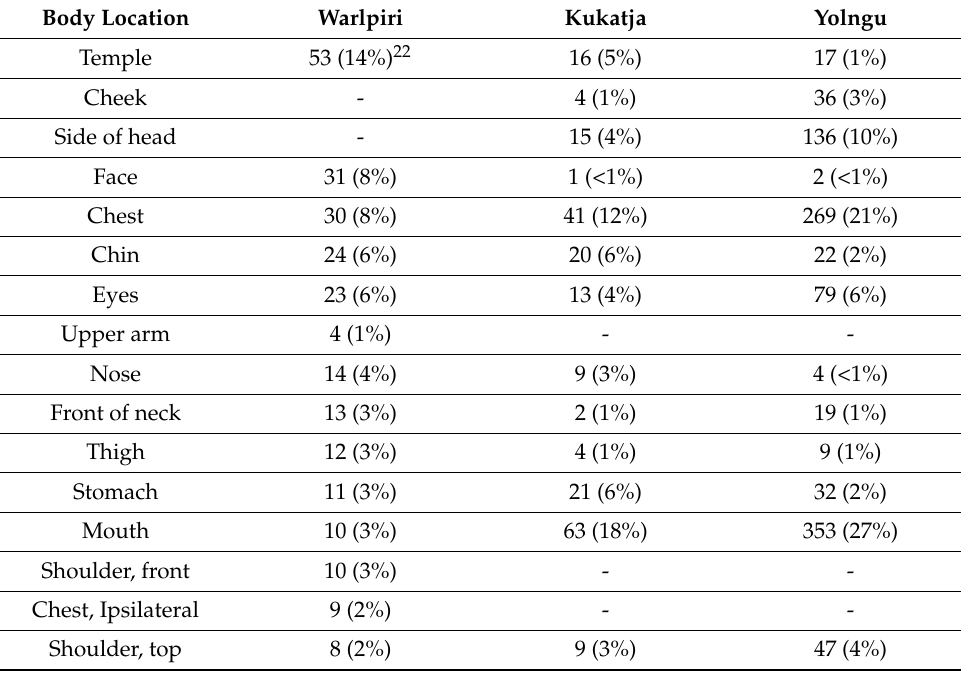
Table 6. Places of articulation on the body in Warlpiri, Kukatja and Yolngu SL. Body